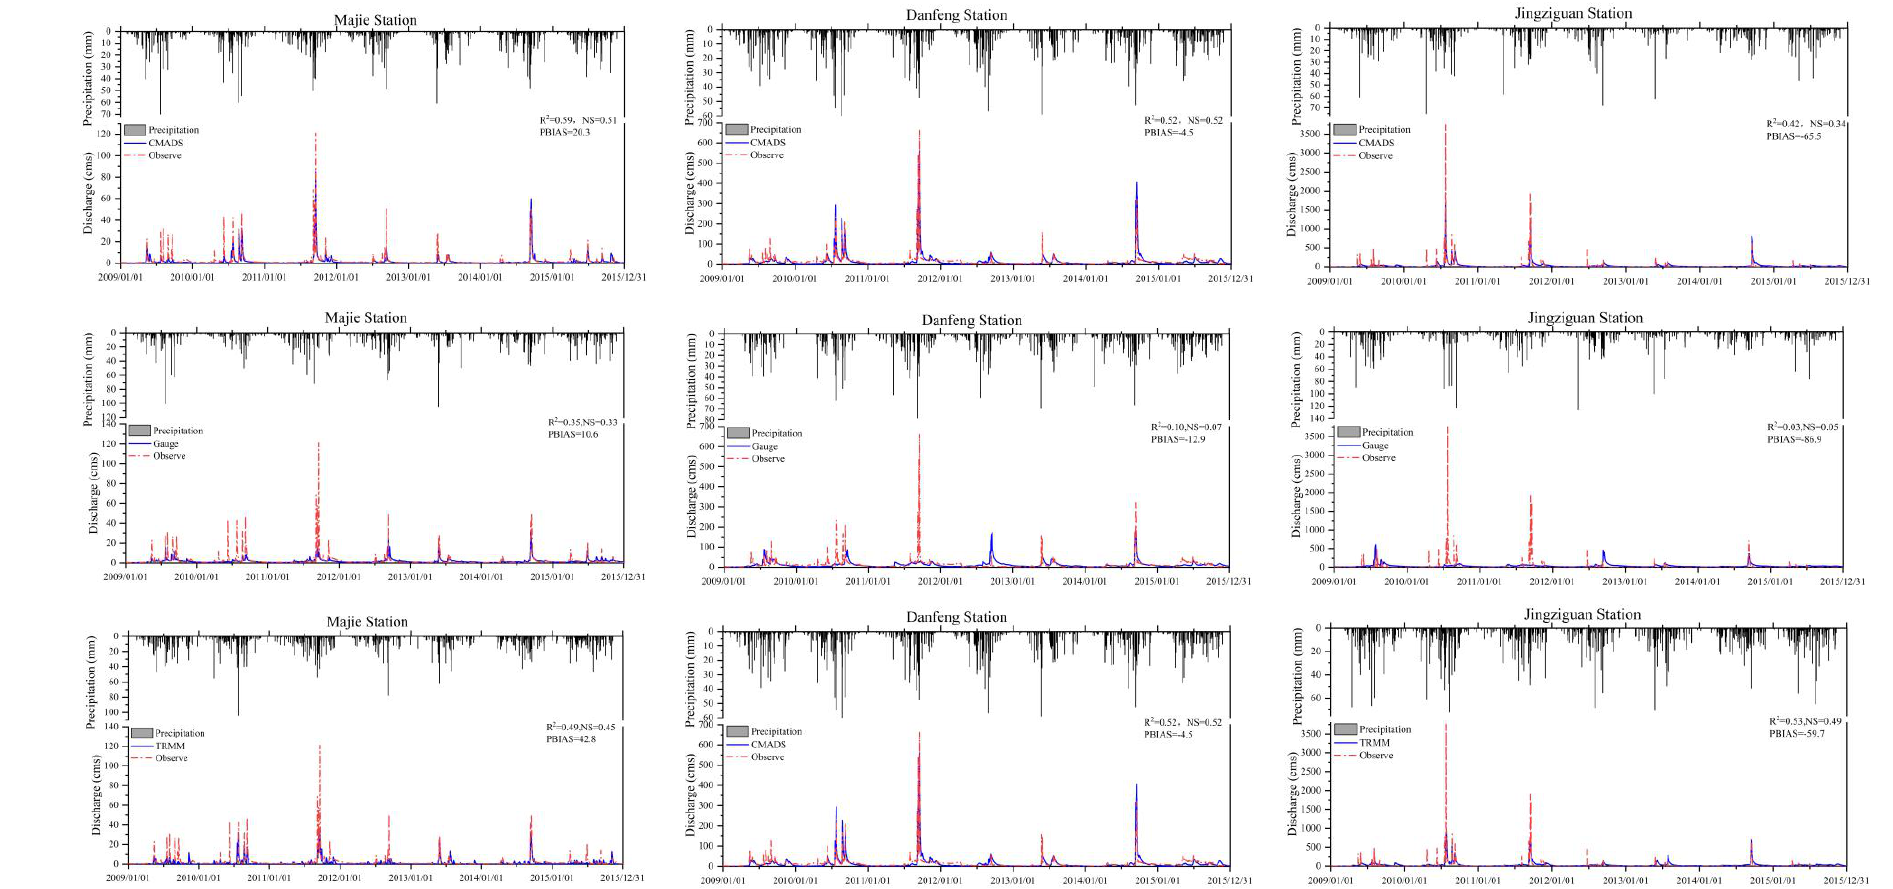
Figure 9. Observed and simulated discharges at Majie Station, Danfeng Station, and Jingziguan Station of the DRB at a daily scale using inputs of Gauge, CMADS, and TRMM. Note that this figure is given as year/month/day.